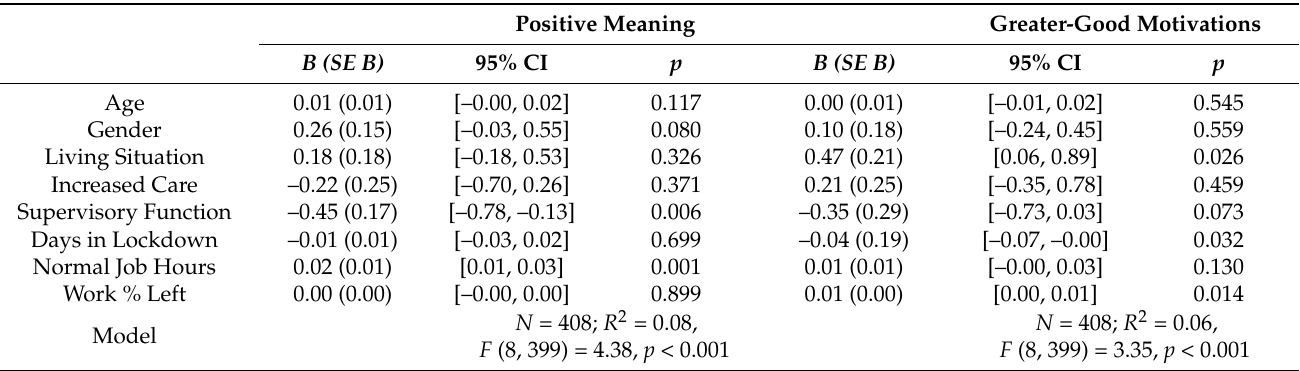
Table 4. Multiple regression analysis of work percentage left on positive meaning and greater-good